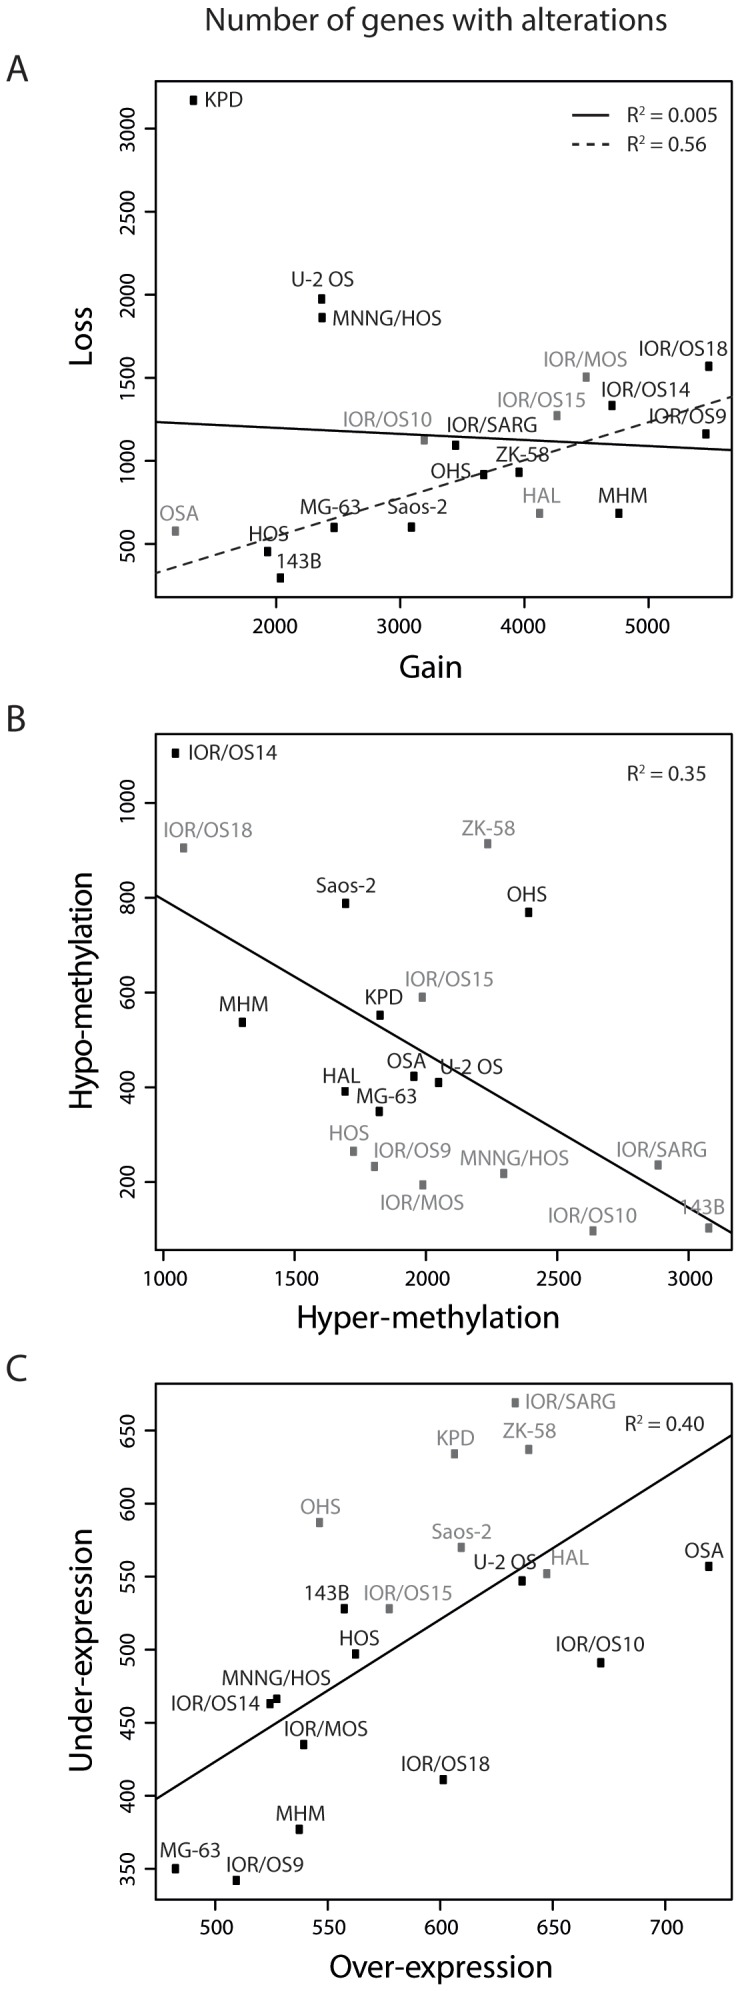
Number of genes with alterations.Plot of the number of genes with (A) gain and loss, (B) hyper- and hypo-methylation and (C) over- and under-expression for all the cell lines. The linear regression line is indicated in black. For the copy number (A), the linear regression line omitting the outlier samples U-2 OS, MNNG/HOS and KPD is indicated with a dashed line. The cell lines are colour-coded in gray and black according to the separation into two main subclusters from the respective unsupervised hierarchical clustering (Figure 1).